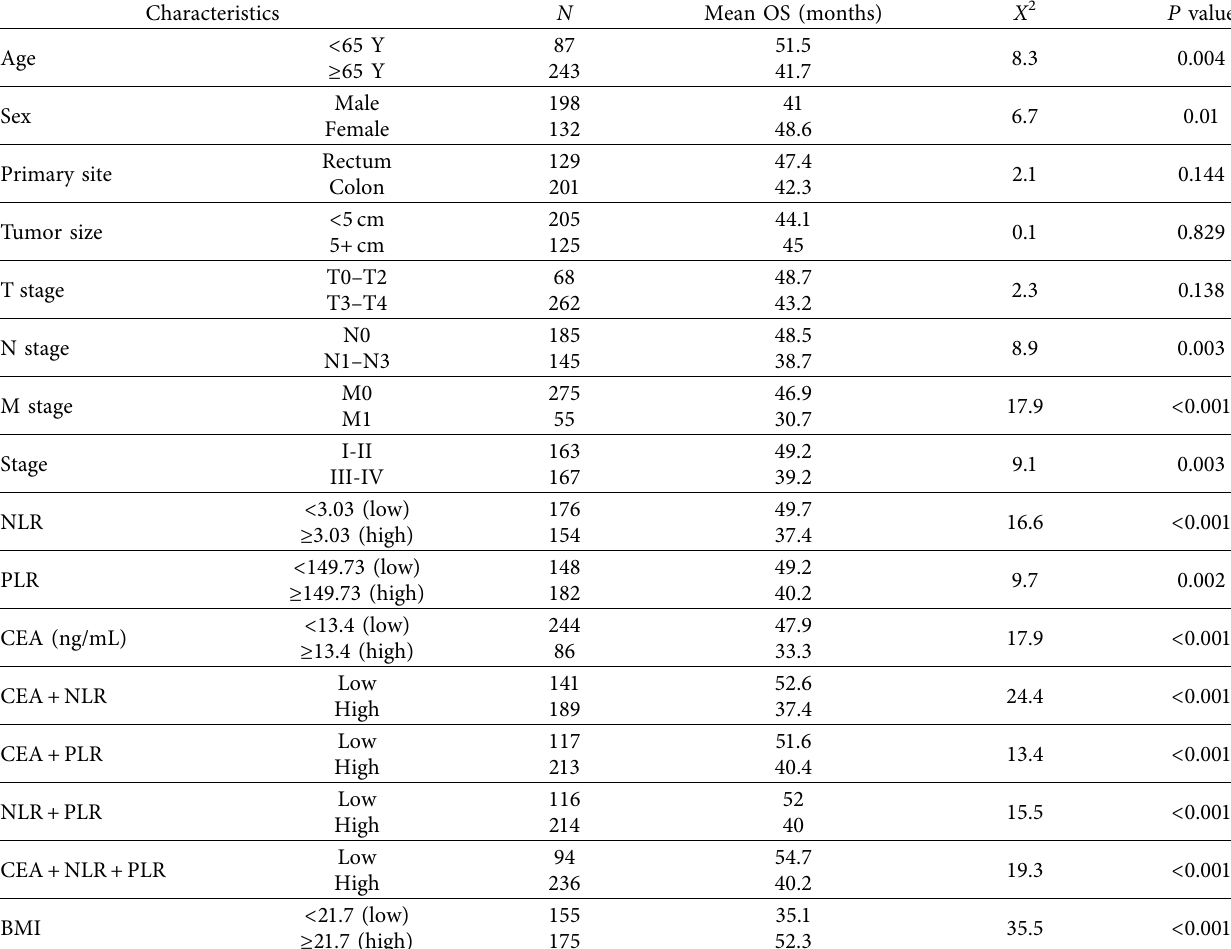
Table 1: Survival analysis using the Kaplan–Meier and compared by the log-rank test.